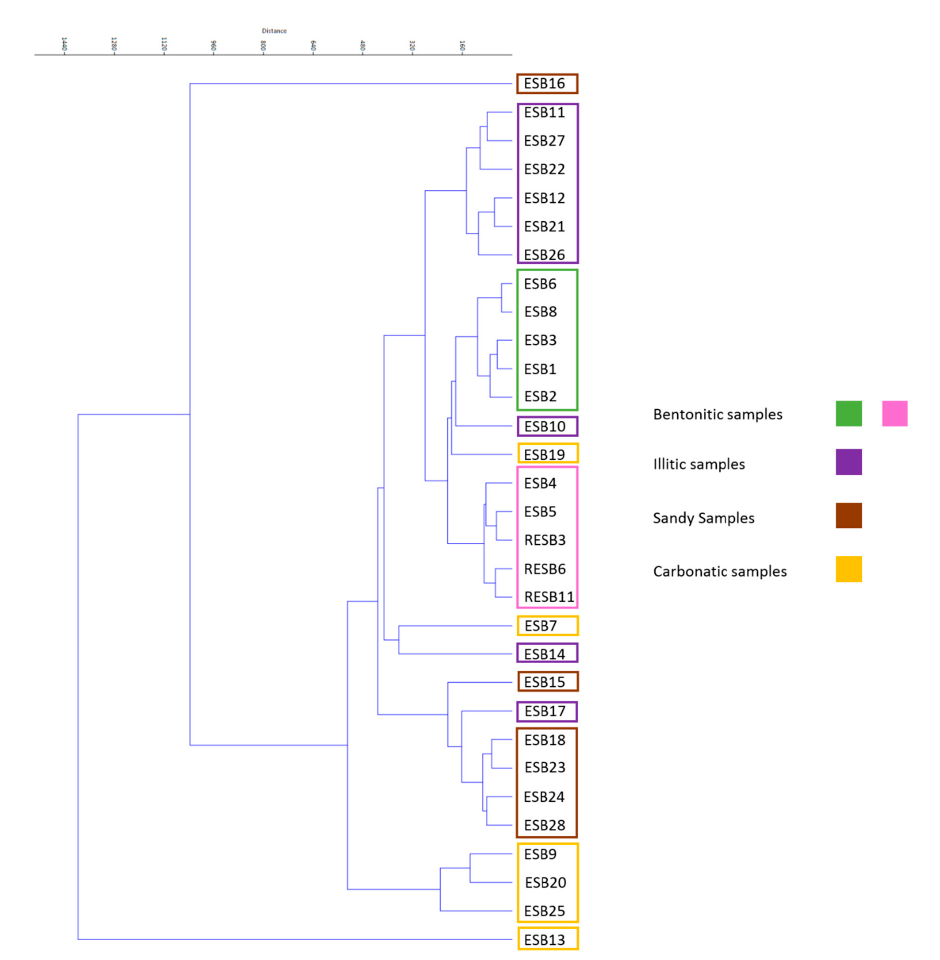
Figure 6. Multivariate cluster of the geochemical data.